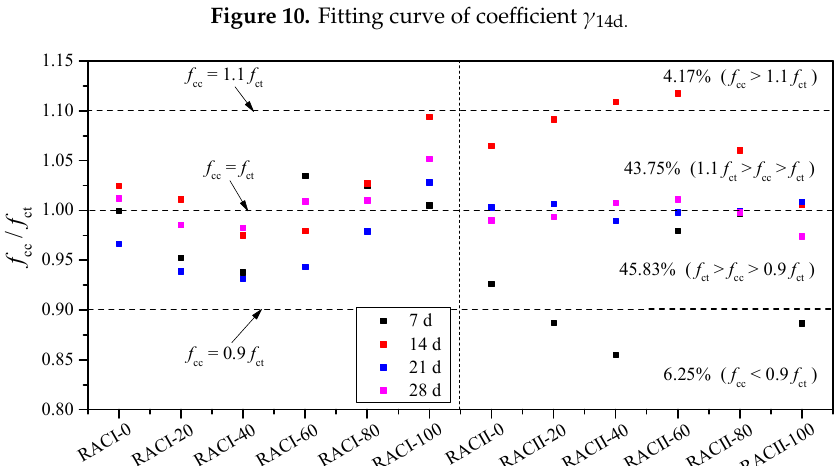
Figure 11. Comparison between the tested and calculated compressive strengths.